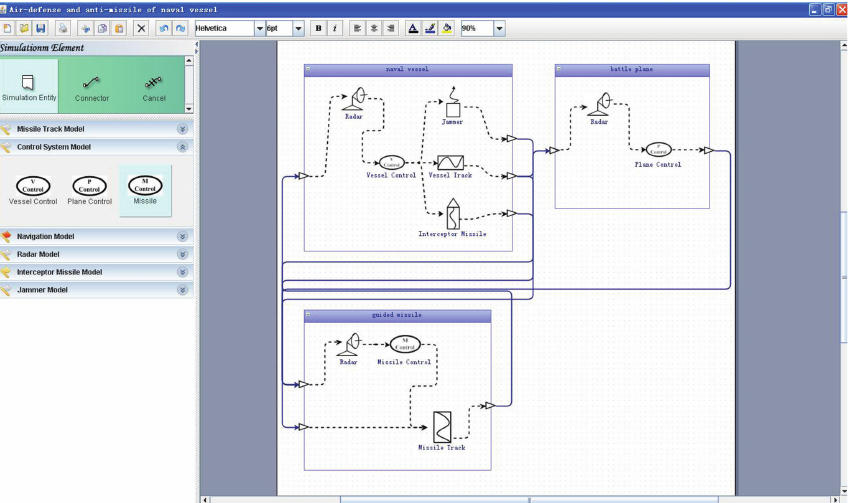
Figure 9: Snapshot of air-defense and antimissile of naval vessel simulation